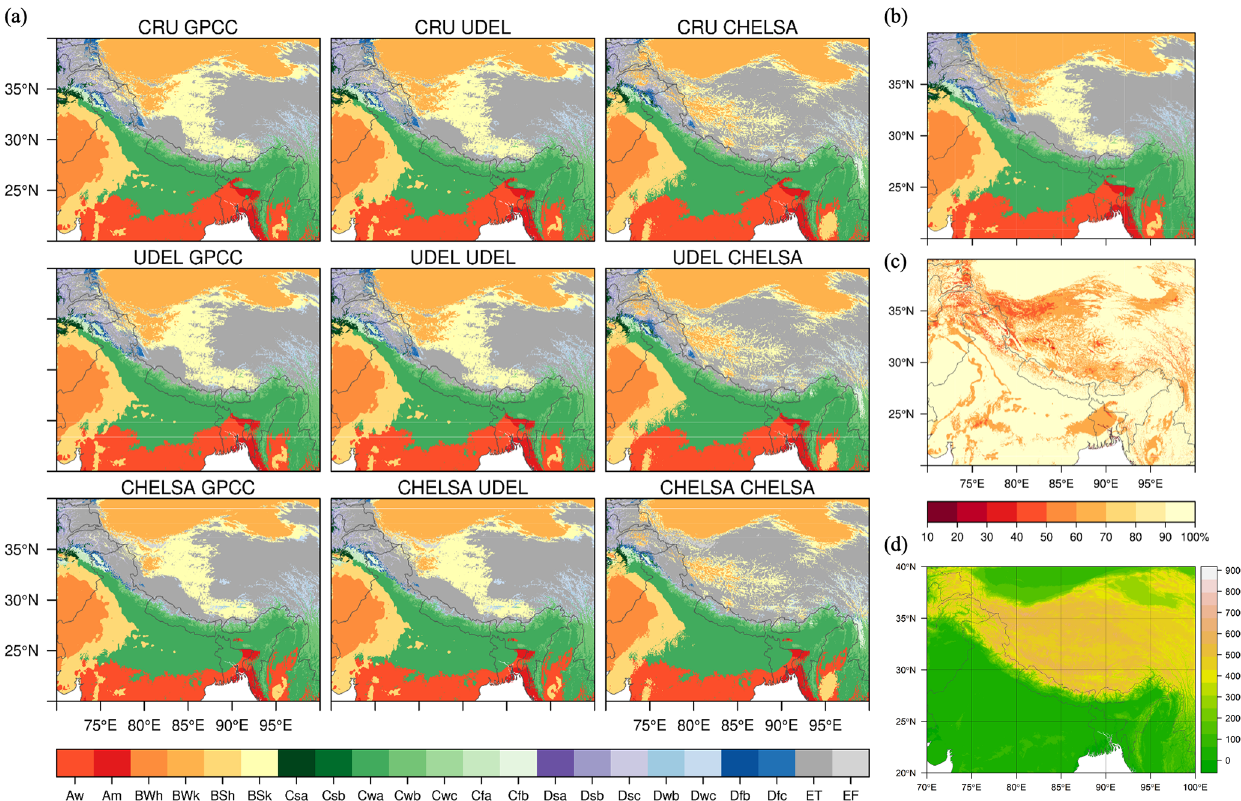
Figure 5. Present Köppen–Geiger classification and confidence map for 1979–2008 with resolution of 1km for the Tibetan Plateau. (a) Cli- mate maps based on the nine combinations of the three precipitation datasets and three surface air temperature datasets, (b) the final climate map derived from the most common climate class among the nine climate maps, (c) confidence level distribution of the final climate map, and (d) elevation map for the Tibetan